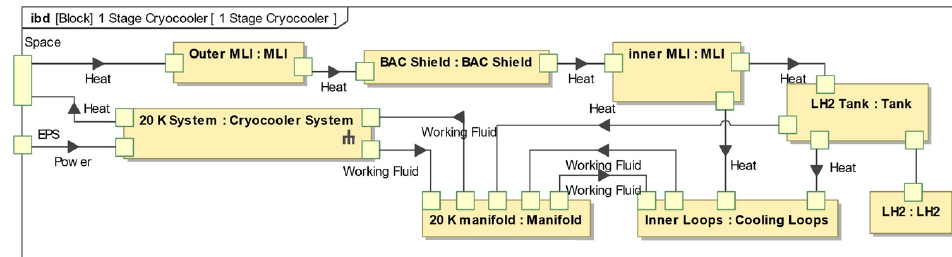
Figure 16. One stage thermal management system IBD.